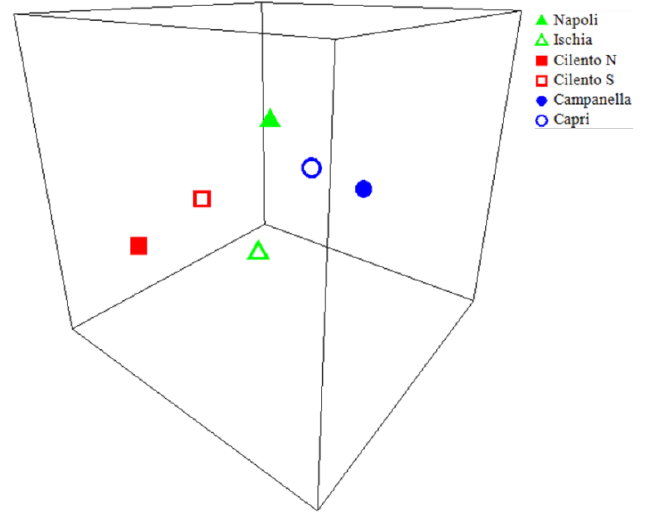
Figure 7. 3D-nMDS plot of anthropogenic pressure, from Euclidian distance matrixes. Points represent centroid of areas levels clusters in 3D multidimensional space, and the distance between any two points represents the difference between those two areas. The high quality of the ordination is indicated by a low-stress value (3D stress = 0.03).